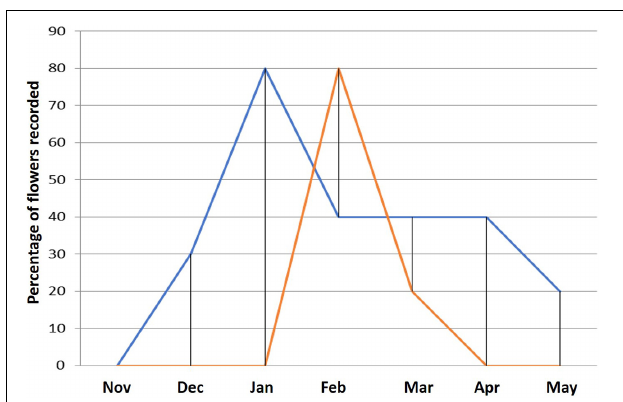
FIGURE 5 | Floral phenology of wild and cultivated potatoes studied. The temporal production of flowers in the wild Solanum candolleanum (line blue) and varieties of cultivated potatoes (line red).